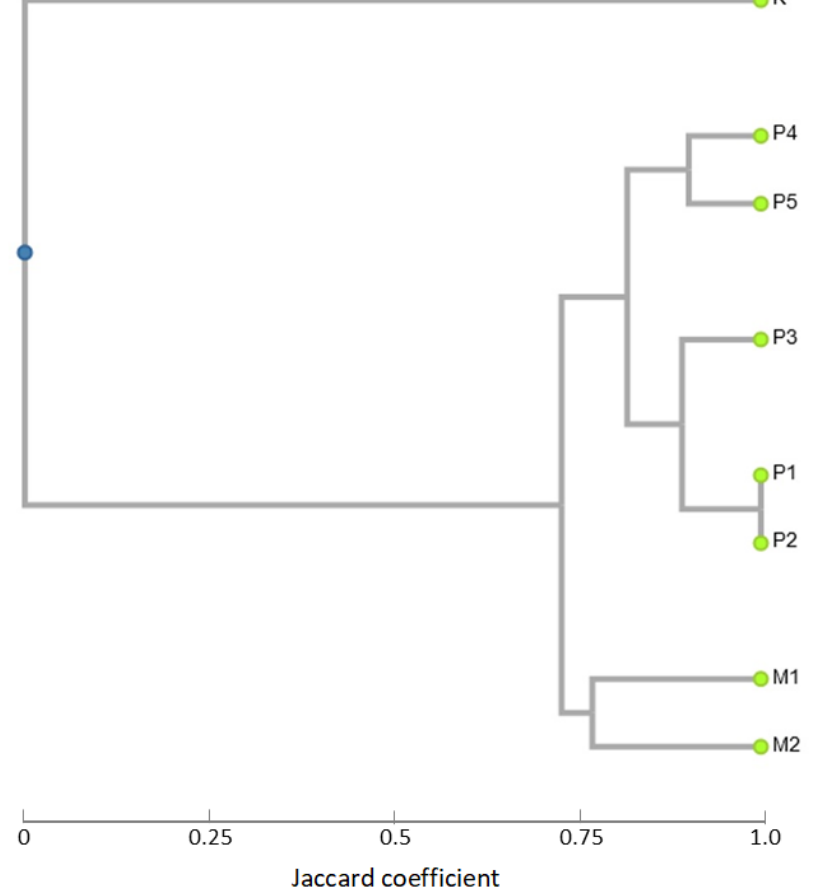
Figure 5. Dendrogram of analyzed C. fragrans genotypes based on iPBS markers.